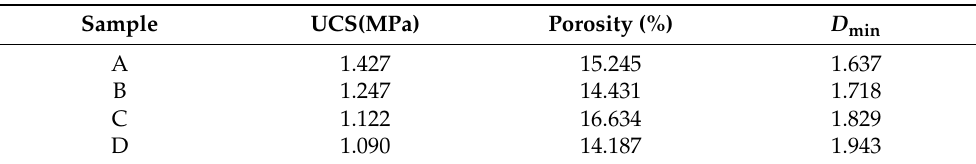
Table 6. The research data of Hu et al. [17].